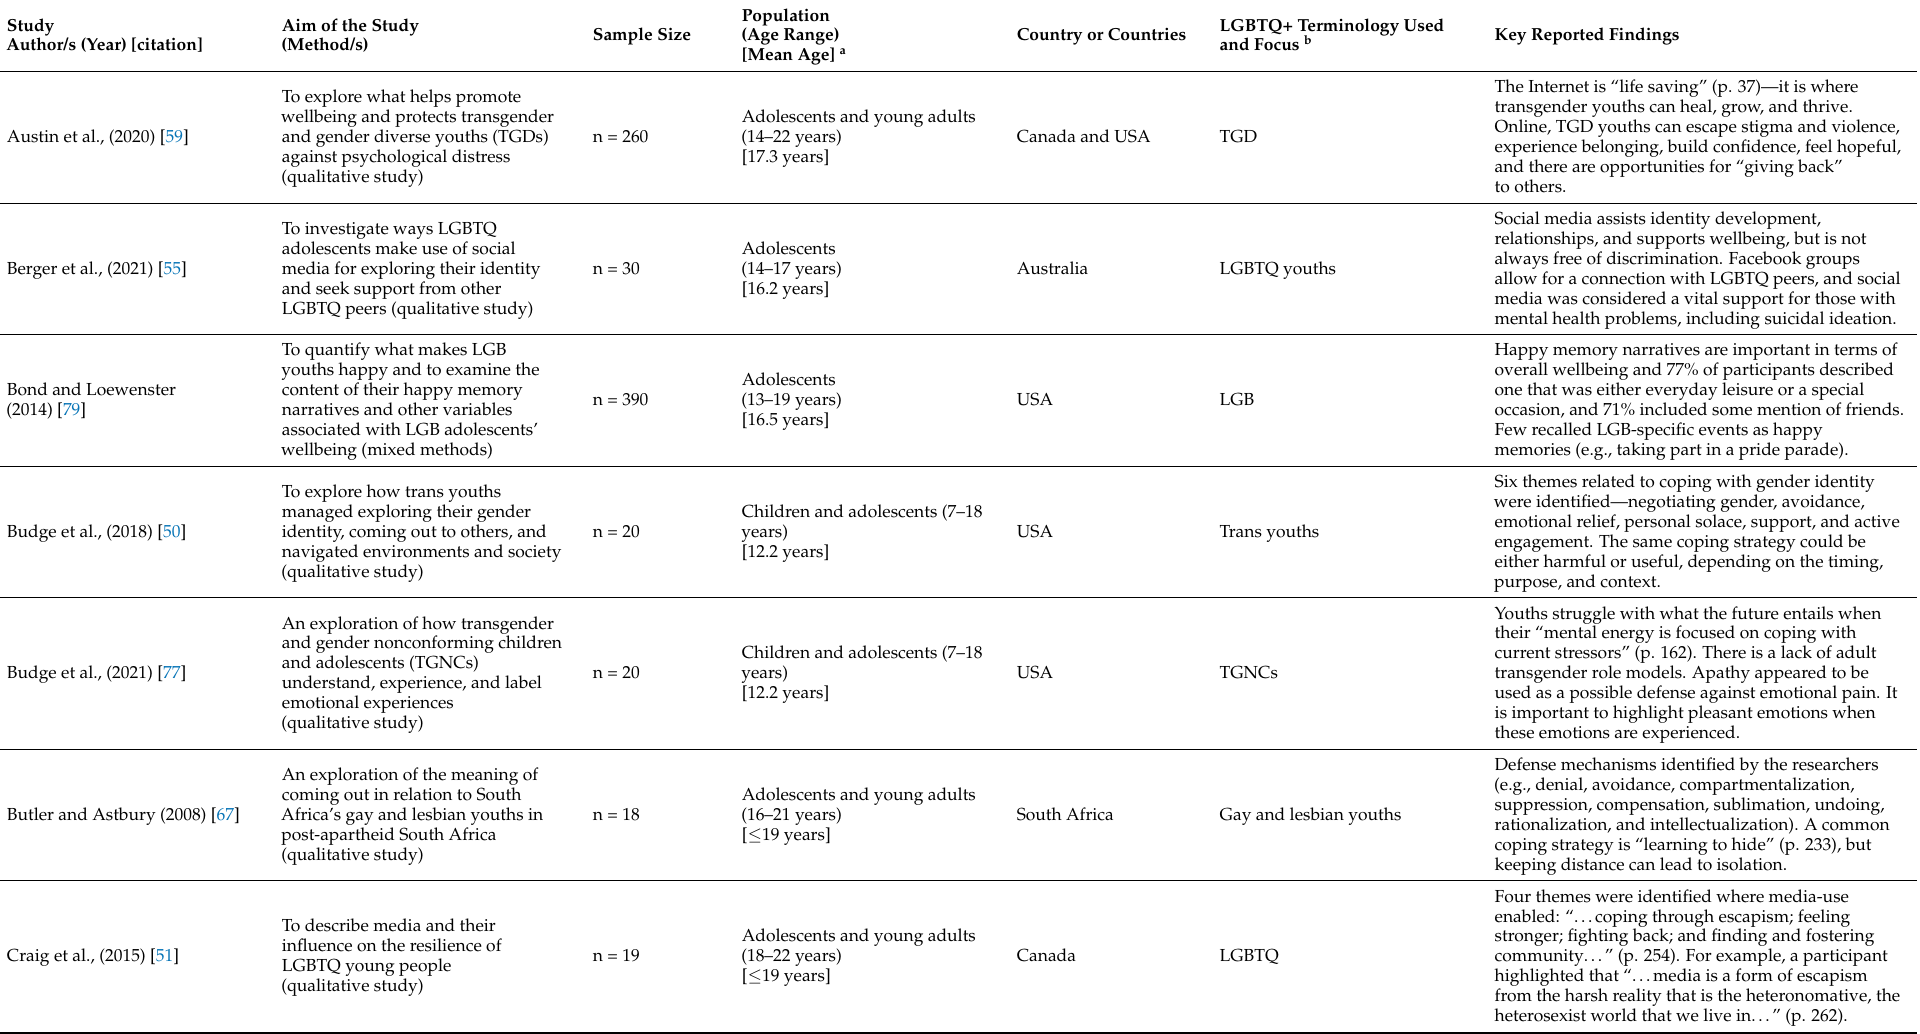
Table 3. Overview of non-intervention-focused studies (n =